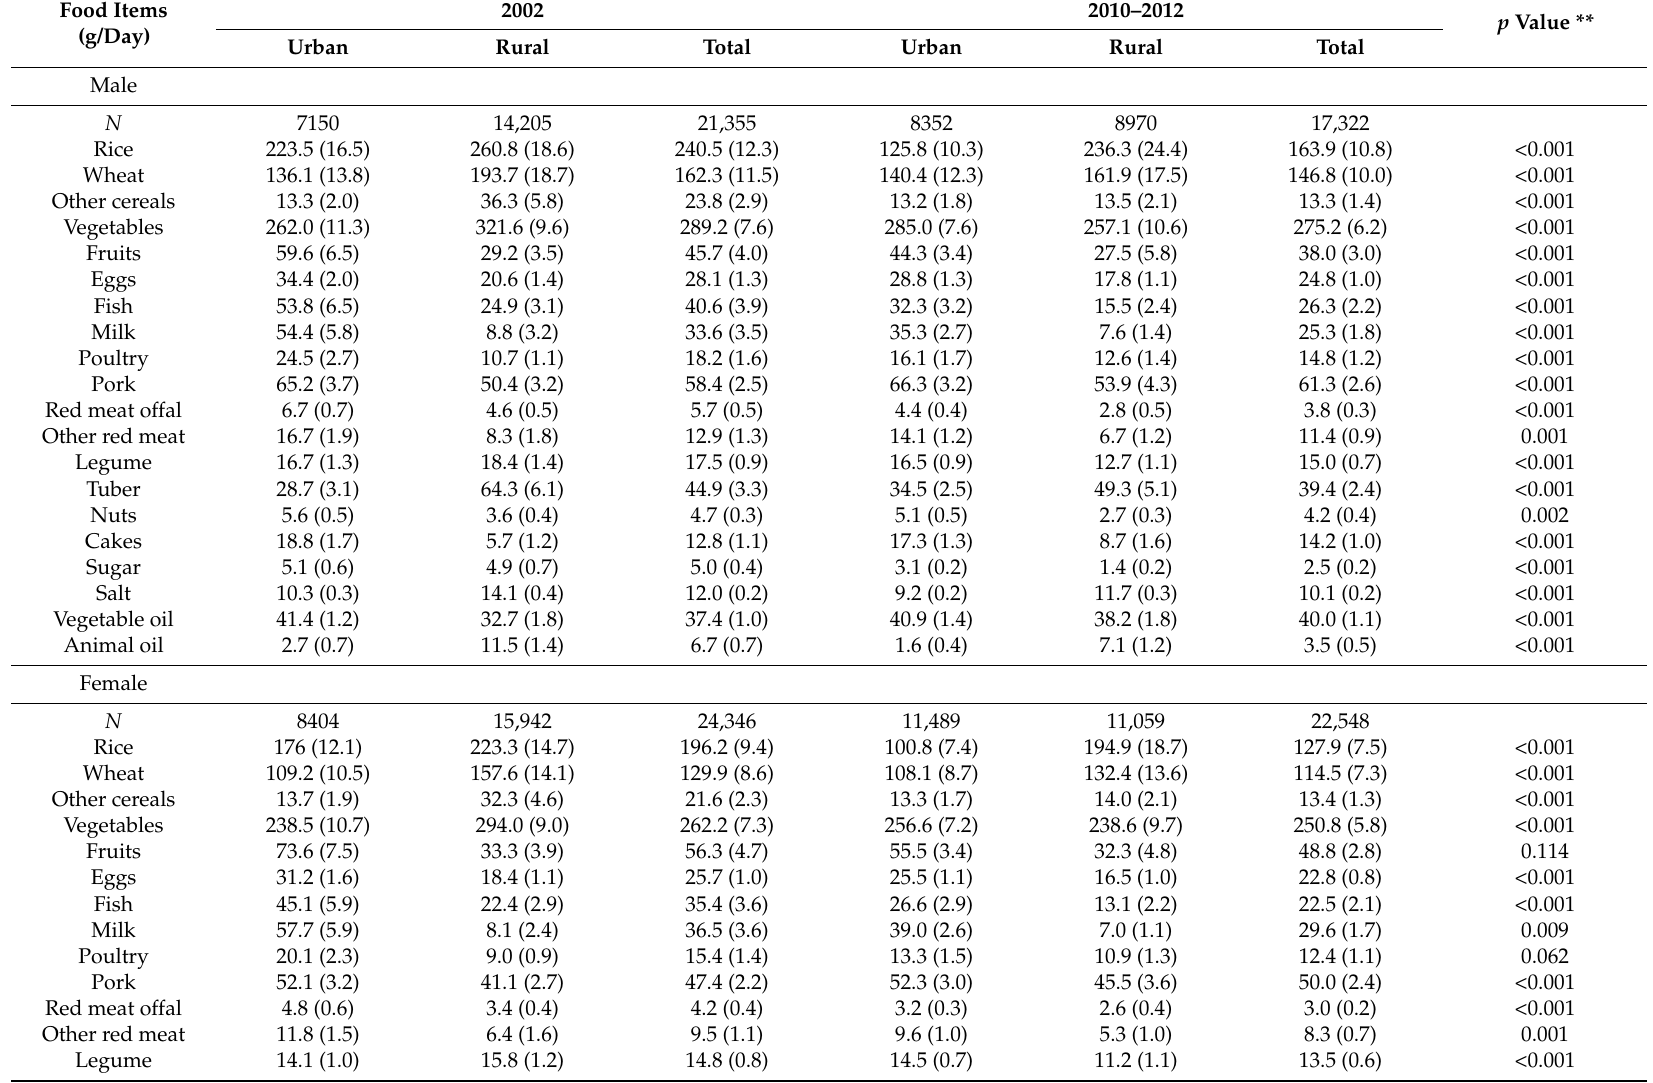
Table 3. Mean (SE) intake of food intake by gender and residence in two surveys